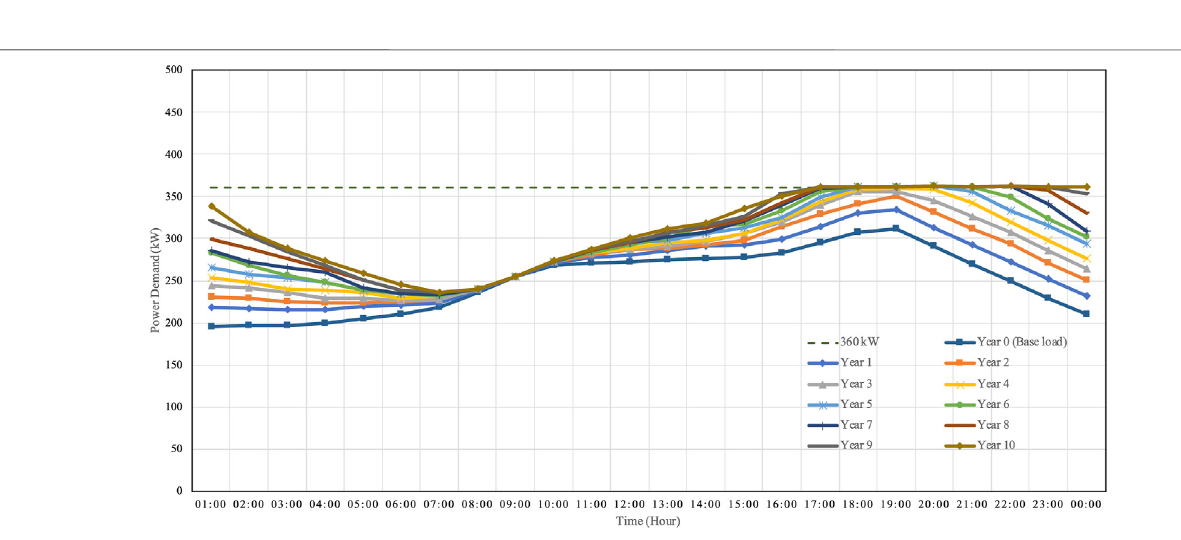
Frontiers in Energy Research |